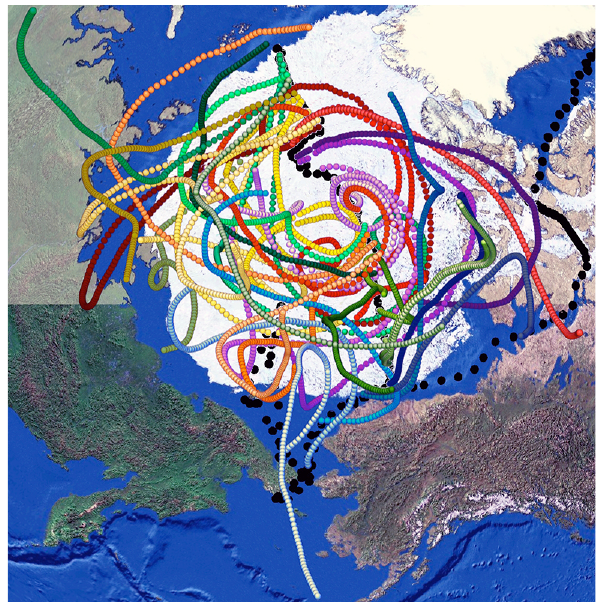
Figure 4 . Cruise track illustrated by ship’s position every 6 h (black dots) and for August (weeks 3-5) and September (weeks 1-3) plots of selected daily five-day back-trajectories starting (usually at 12 h UTC) at 300-2,500 m above sea level. The offset in starting elevation was chosen individually to produce a purposeful stable trajectory lacking of significant ground contact. The snow/ice coverage shown in the image does not represent the actual distribution during the cruise.